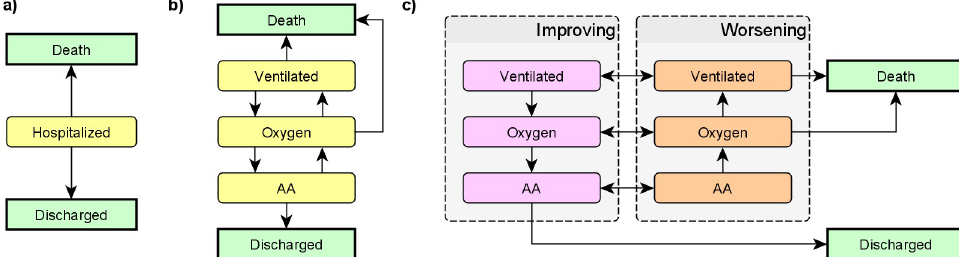
Fig 1. States used in the competing risk model (a) and in the two hidden Markov model variants (b,c). AA = Ambient air, Oxygen = Nasal oxygen, Ventilated = any form of ventilation (non-invasive positive-pressure ventilation, mechanical ventilation and extra-corporeal membrane oxygenation). In all models the ‘Death’ and ‘Discharged’ states are terminal. In the second hidden Markov model (c), the ‘Improving’ and ‘Worsening’ variants of each non-terminal state are not observable—only the breathing support is observed and improving/worsening is inferred from progression of the